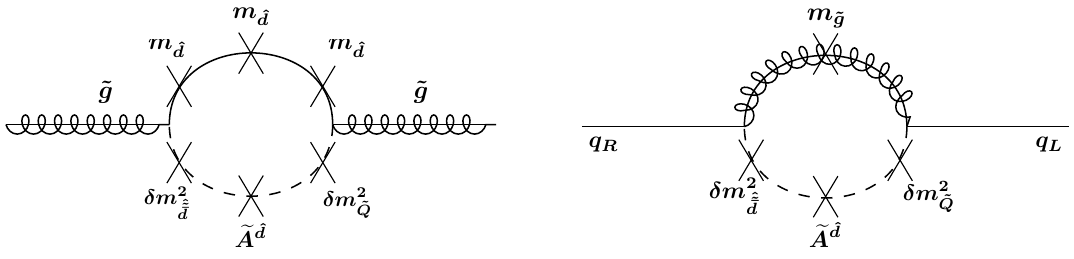
Figure 2 . Radiative corrections to the phase of the gluino mass (the left panel) and quark mass (the right panel) induced by flavor violating SUSY-breaking parameters, δm 2 In the second relation, we have used e A ˆ d ∼ y ˆ d m which are dominated by the radiative correction of the top Yukawa coupling. Note that δθ m (cid:16) (cid:17) † vanishes for δm ∼ y ˆ d y ˆ d m 2 / 16 π 2 because of the hermiticity. Therefore, the constraint ˆ˜¯ soft d from δm 2 in eq. (3.9) is ˜ Q